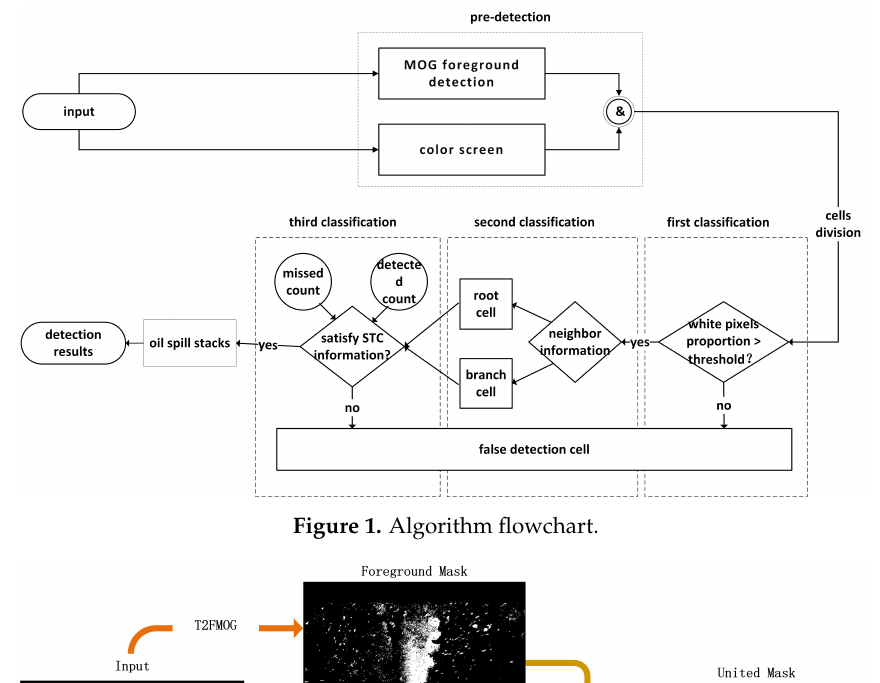
Figure 1. Algorithm flowchart.